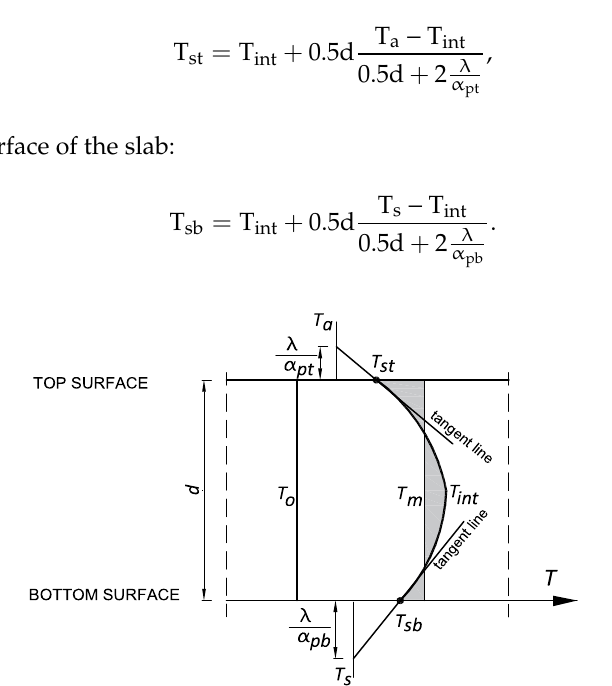
Figure 2. Distribution of temperature at the thickness of the slab.